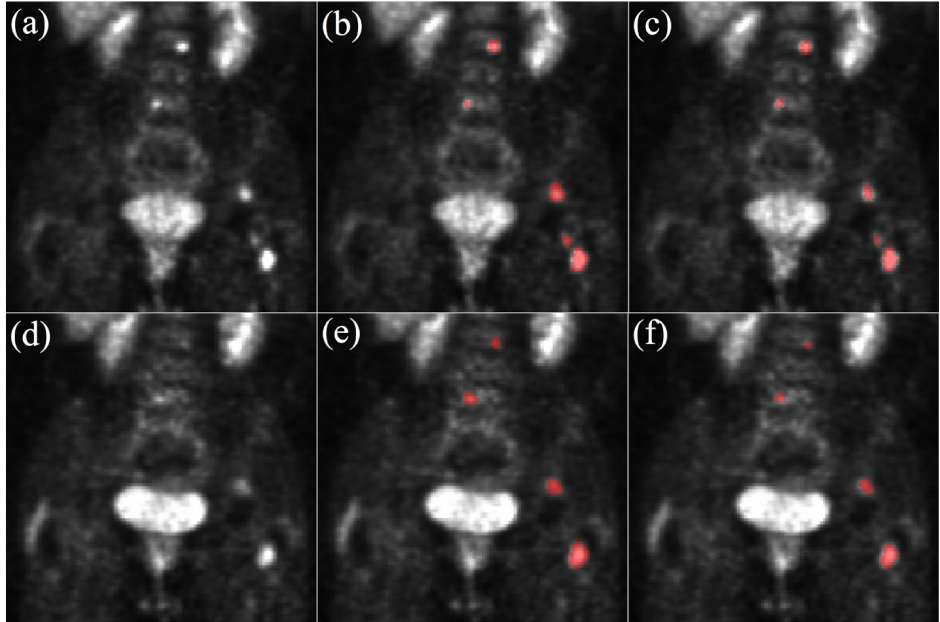
Figure 2. Segmentation examples on two acquisitions from the same patient. ( a ) PET BL, ( b ) GT BL, are visible. Due to the patient’s response to treatment, lesions on PET FU have a lower contrast than on PET BL and are less visible. BL = Baseline, GT = Ground Truth, FU =